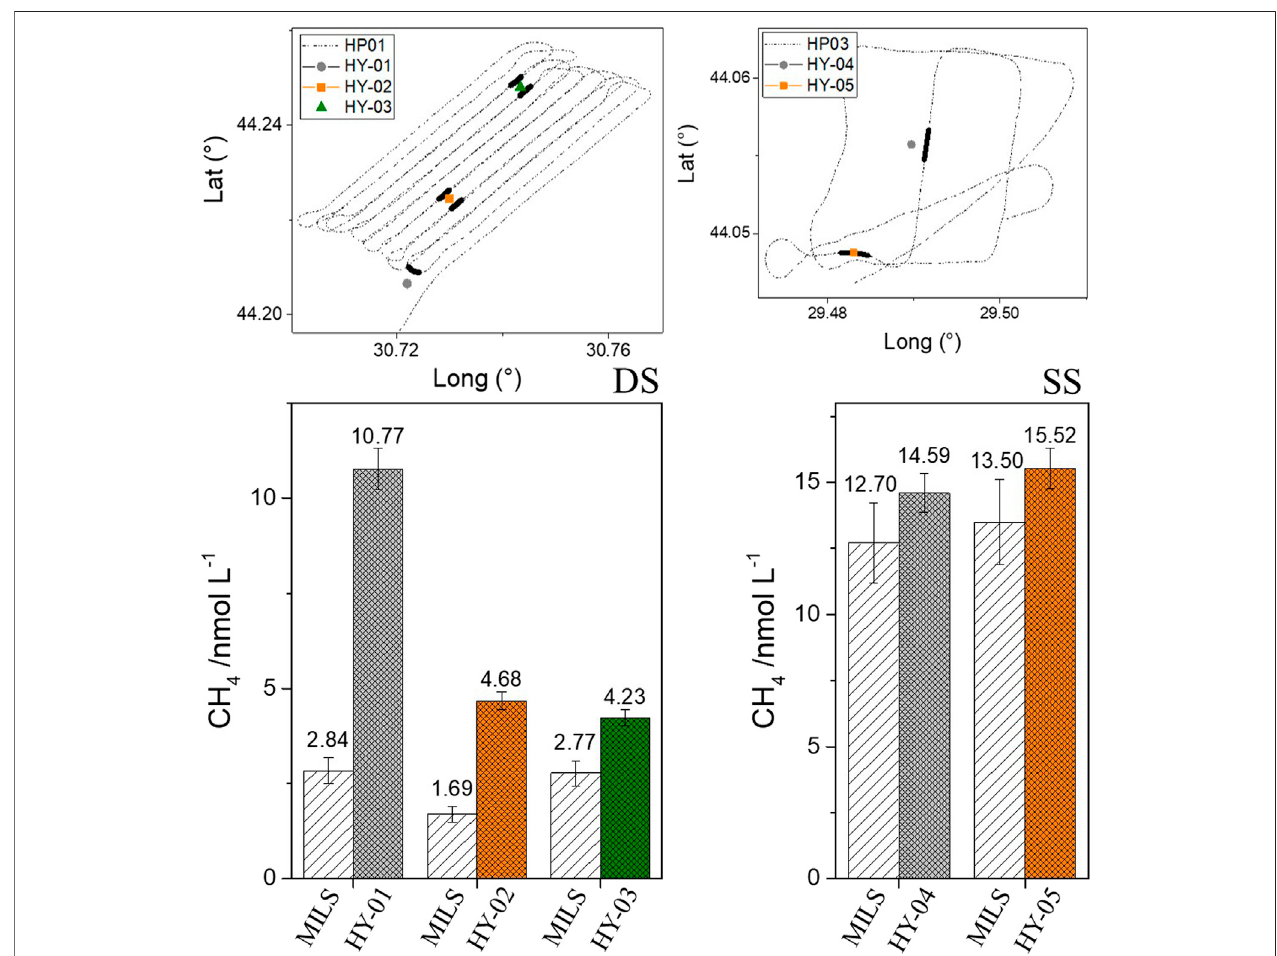
FIGURE 6 | Bottom: Comparison between near-surface water depth measurements made by the MILS sensor and the analysis of discrete samples (HY) at the deeper (DS, left) and shallower (SS, right) site. Datafrom discrete samples are reported as theaverage between the twoanalytical techniques used (PT and HS). Maps withlocationsarereportedatthetop,withthetrajectoriesoftheMILSsurveys(dottedlines)andlocationsofthenearseasurfacesamplingoftheHYs.Inthickblacklines are the selected dissolved CH 4 MILS data closest to the discrete sampling locations which were averaged and used for the comparison.